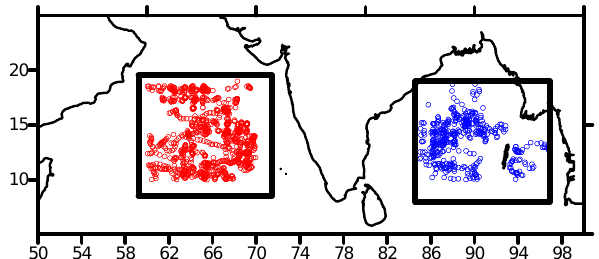
Fig. 1. Locations of Argo Float profiles in Bay of Bengal and Ara- bian Sea representative areas during 2003 and